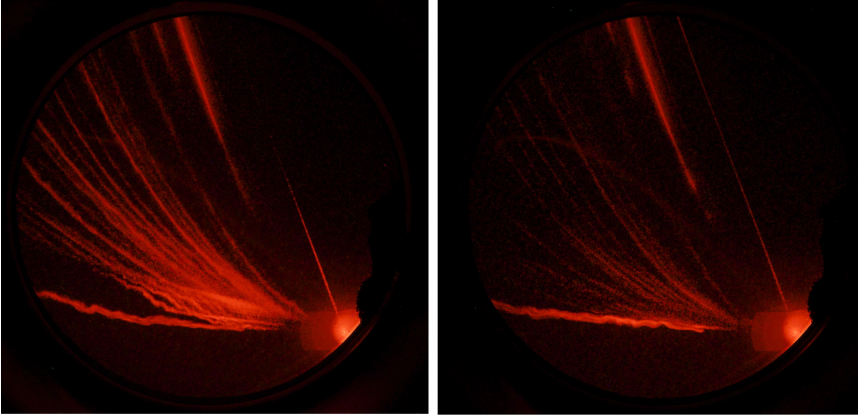
Figure 1. Typical Thomson parabola (TP) snapshots showing distorted ion tracks. Parabola parts corresponding to high-energy particles partially overlapped with each